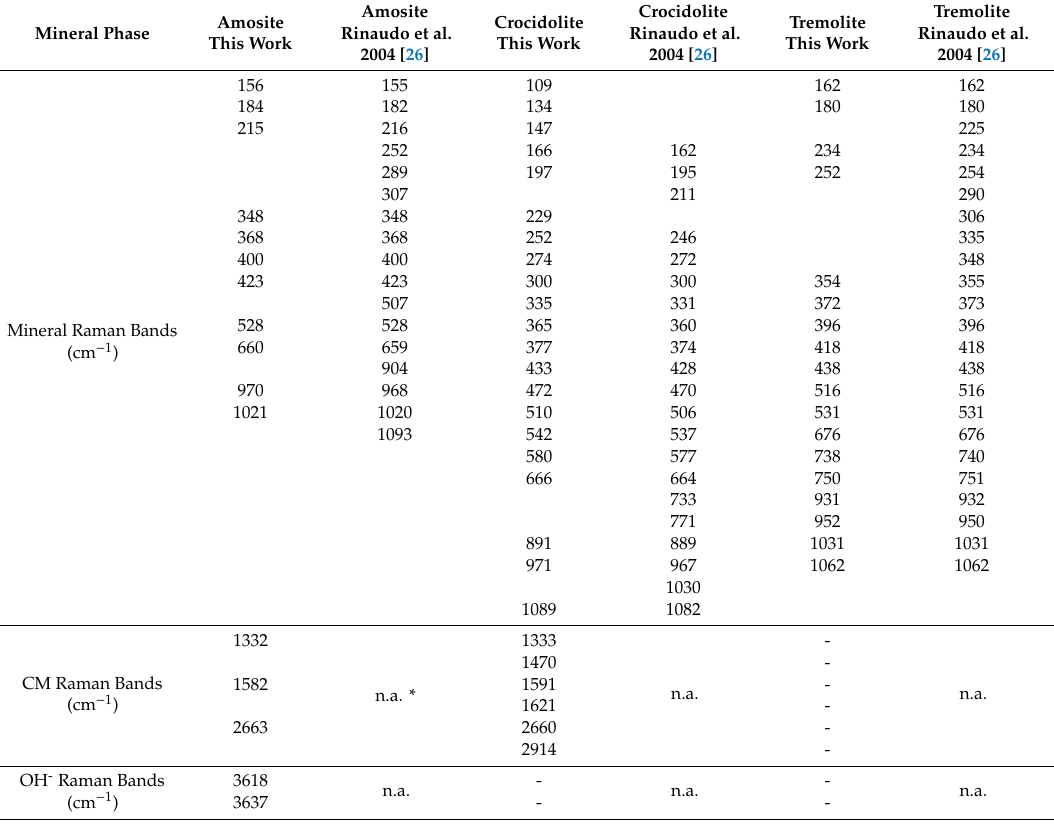
Table 1. Raman bands observed on the mineral phases defined “asbestos” by the Law. Mineral Phase